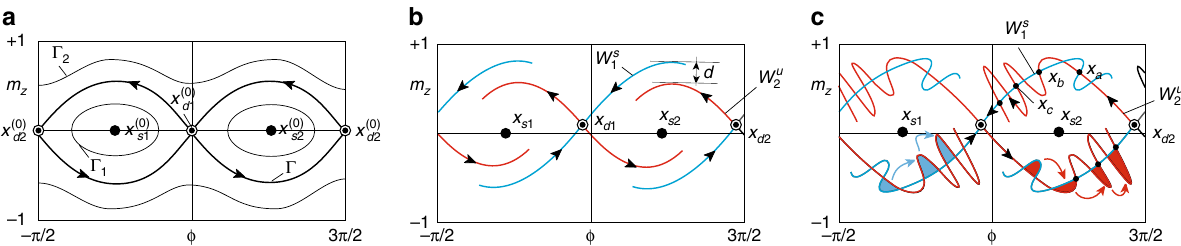
(cid:5) (cid:6) . The manifold intersection points > β crit x ac